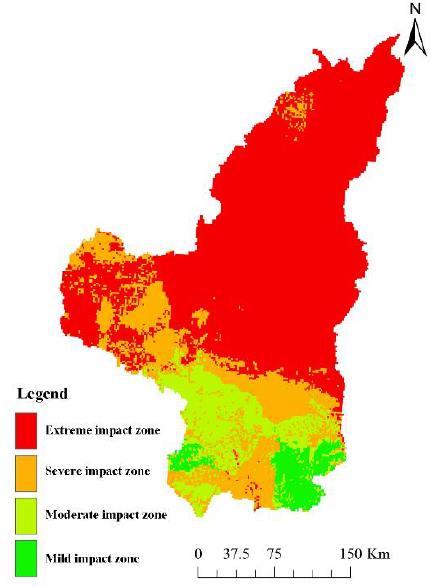
Figure 9. Impact zoning map of the ESV.